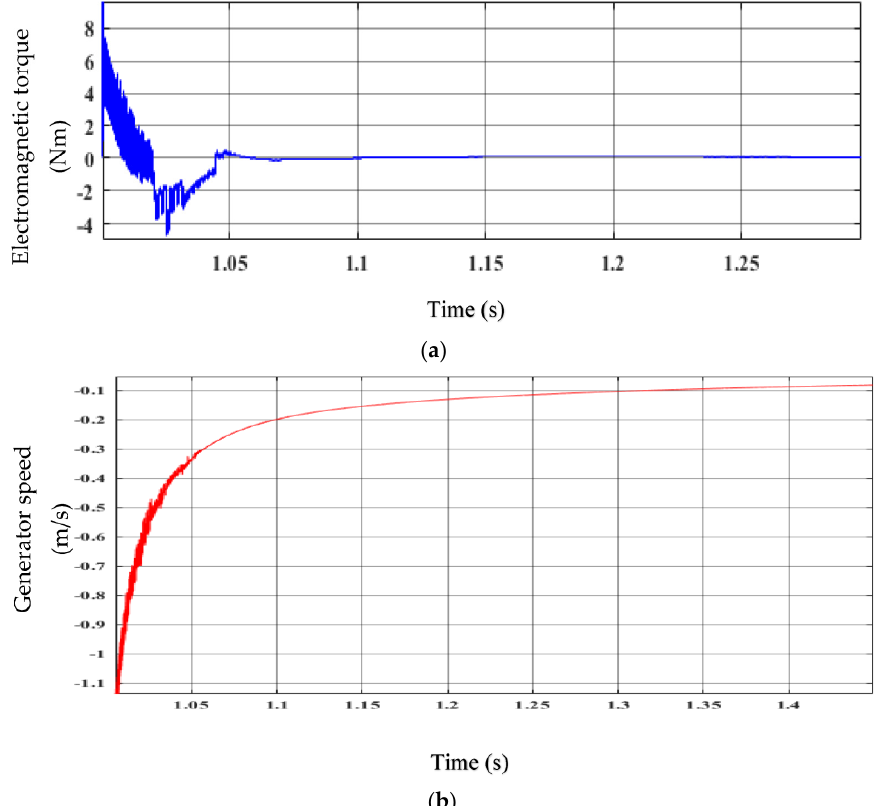
Figure 7. Performance of the EFLC: ( a ) electromagnetic torque and ( b ) generator’s rotor speed. The three-phase voltage ( L ac ) and three-phase current ( h abc ) of the synchronous gen- erator are shown in Figure 8a,b. The phase voltages ( L abc ) from the start of the graph to time t = 1.055 s reveal a strong ripple. The waveform’s ripple started to flatten and ap- proach a steady state at t = 1.055 s. At t = 1.055 s, the current’s stability can be shown in Figure 8b. At this point, the ripple is at its lowest point. As a result, the controller demon- strates its capacity to control the generator’s voltage and current.